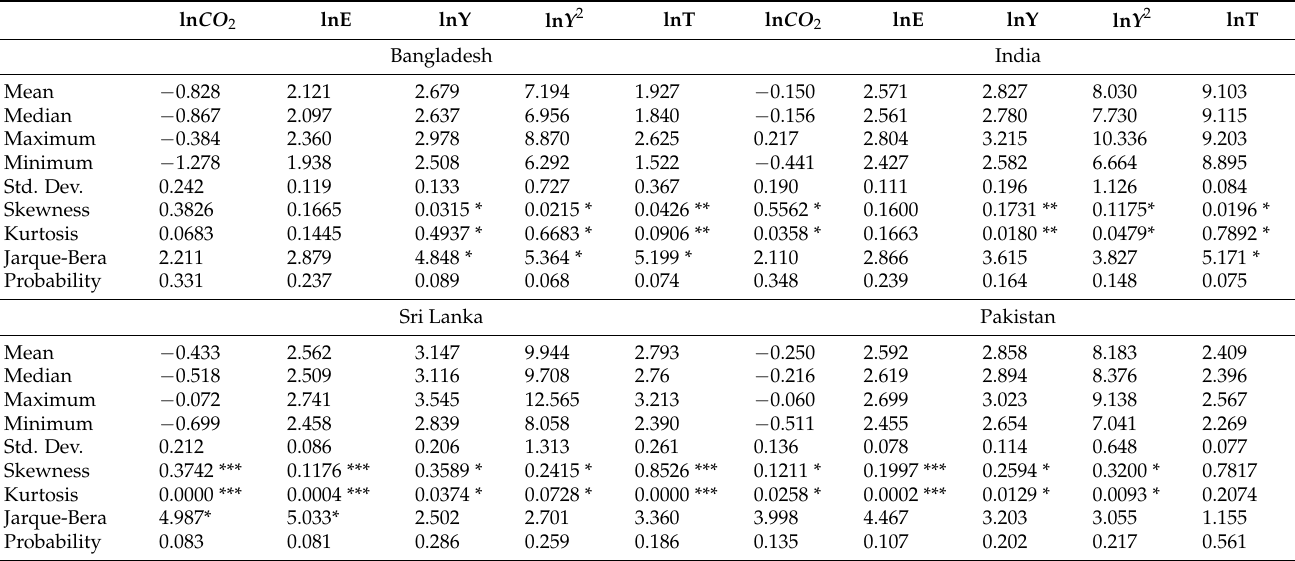
Table 2. Descriptive statistics of the